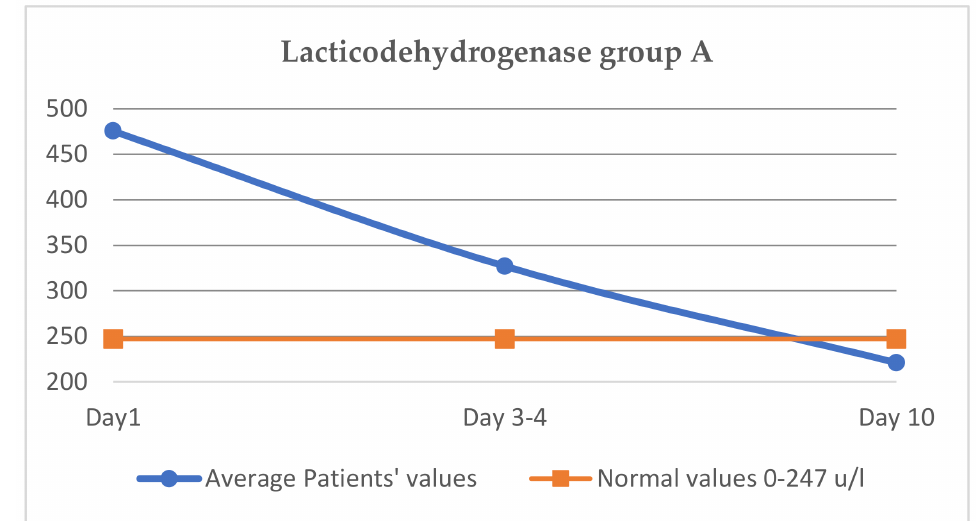
Figure 2. Variation of lactic dehydrogenase group A. 3.5. Evaluation of Ferritin (Normal Values 10–291 ng/mL, in Cytokine Storm, Increases to over 700 ng/mL) The average value of ferritin in day 1 of the treatment was 860.1 ng/mL, on day 3–4 it was 721.0 ng/mL and on day 10 it reached 302.8 ng/mL, very close to normal values (Figure 3).